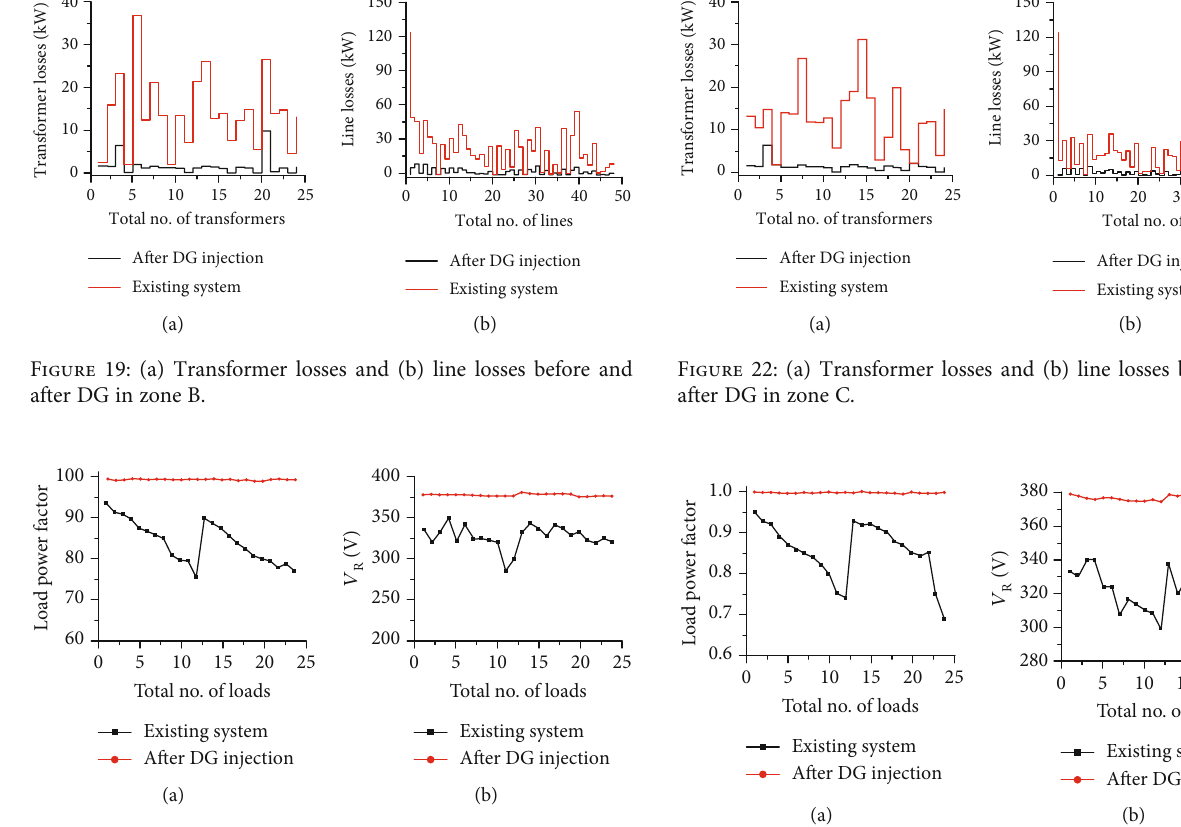
Figure 20: (a) Power factor and (b) voltage at the receiving end in zone B.